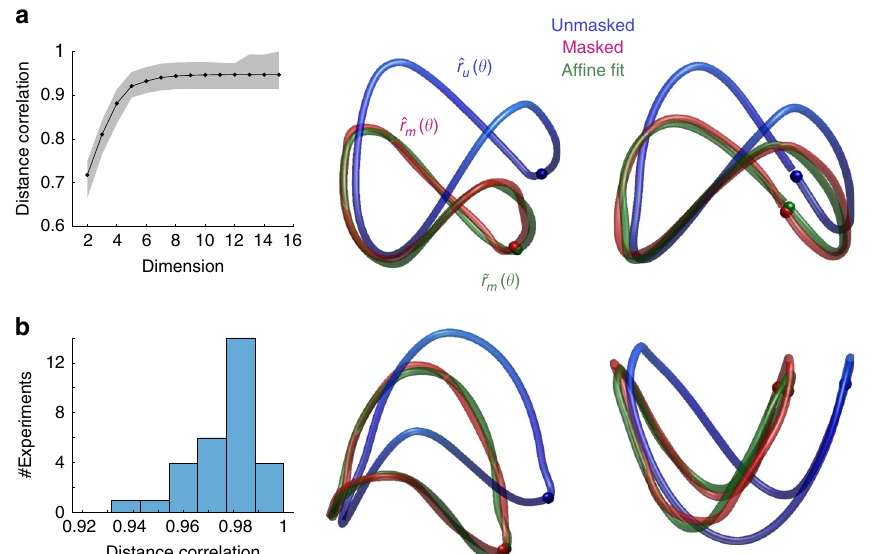
Fig. 7 A simple geometric transformation accounts for the effects of masking in neural populations. a Multidimensional scaling indicates the data can be faithfully embedded in fi ve dimensions. The y -axis represents the correlation between mutual distances in the native space and the low-dimensional embedding. Solid curve represents mean across all experiments; shaded area represent ± 2 SEM. b Fits of an af fi ne model to low-dimensional representations of ^ r u θ ð Þ and ^ r m θ ð Þ in four different experiments. In each case, ^ r u θ ð Þ represents the population response in the unmasked condition (blue), ^ r θ ð Þ represents the population response in the masked condition (red), and ~ r θ ð Þ is the best fi t to the response in the masked condition by means of an m m af fi ne transform. The curves are 2D projections of the fi ve-dimensional fi ts. ( c ) Distribution of the correlation between the mutual distances between points in ^ r m θ ð Þ and corresponding points in the fi t ~ r m θ ð Þ : The high correlation values agree with the visual impression in ( b ) that the fi ts are of excellent